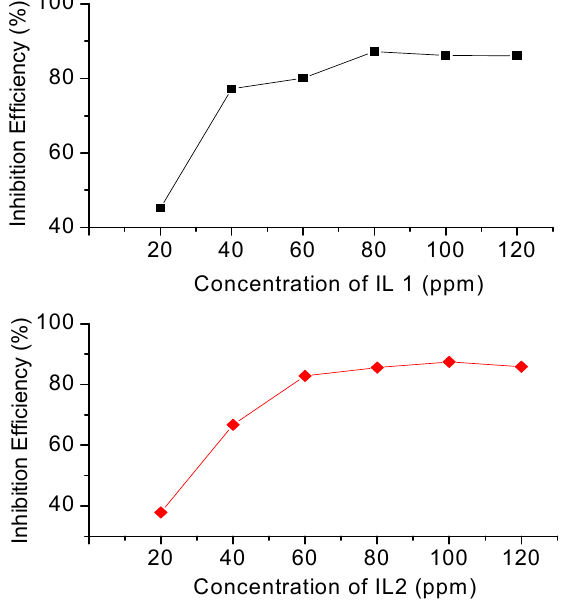
Figure 3. Inhibition efficiency of ILs at various concentrations at a temperature of 25°C.